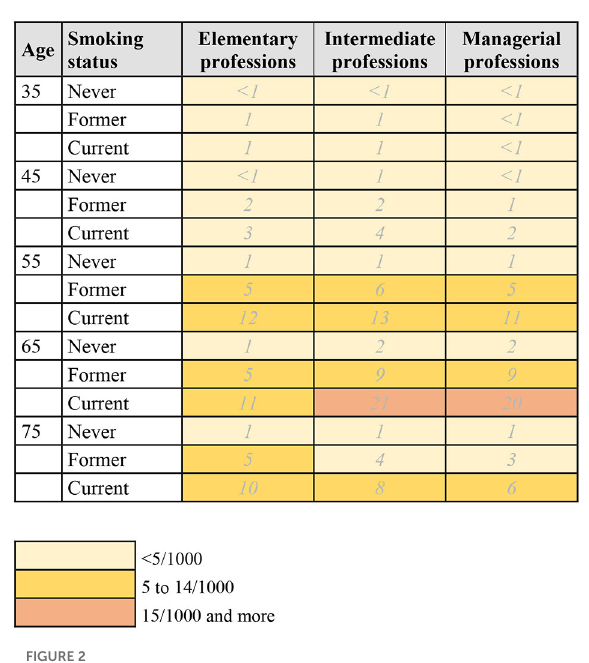
FIGURE2 10-year risk chart of lung cancer for women by occupational group and smoking status. The chart indicates the number of women per